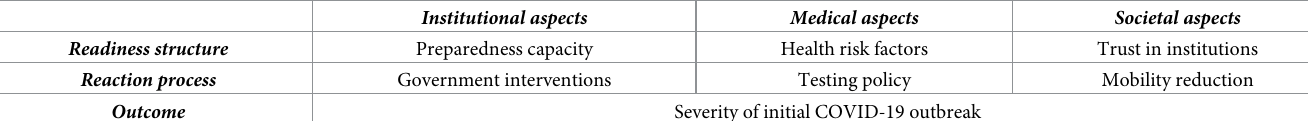
Table 1. Framework for multidimensional assessment of country readiness and reaction to COVID-19